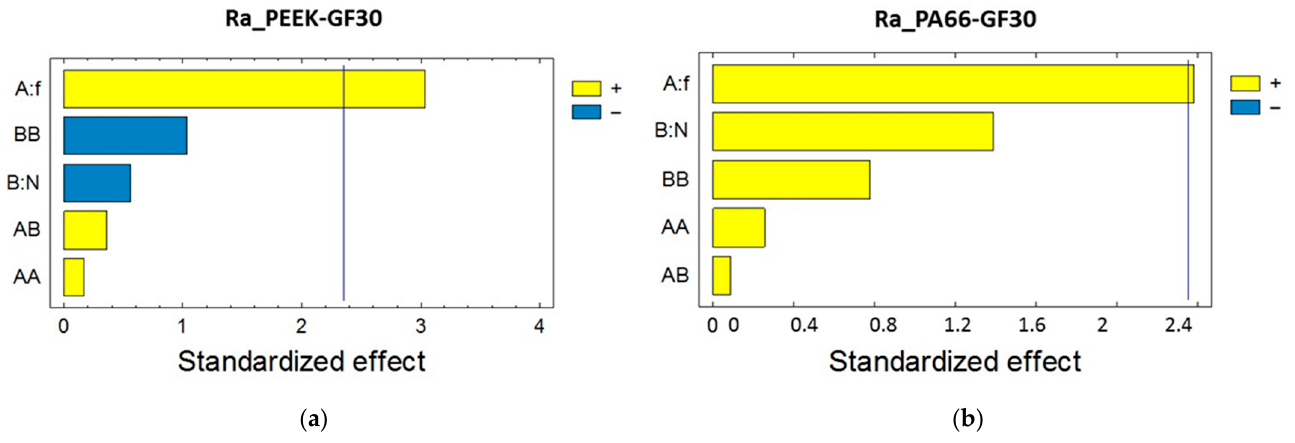
Figure 4. Standardized Pareto chart for roughness at a 90% confidence level: ( a ) standardized effect for Ra_PEEK-GF30 [dimensionless] and ( b ) standardized effect for Ra_PA66-GF30 [dimensionless]. Their percentage contributions were 67.05% in PEEK-GF30 and 50.37% in PA66-GF30.